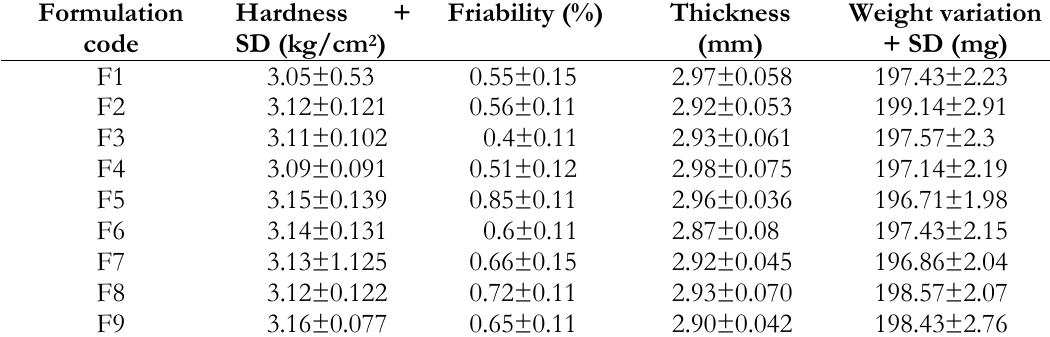
Table VI. Evaluation of post-compression parameters of fast dissolving tablets